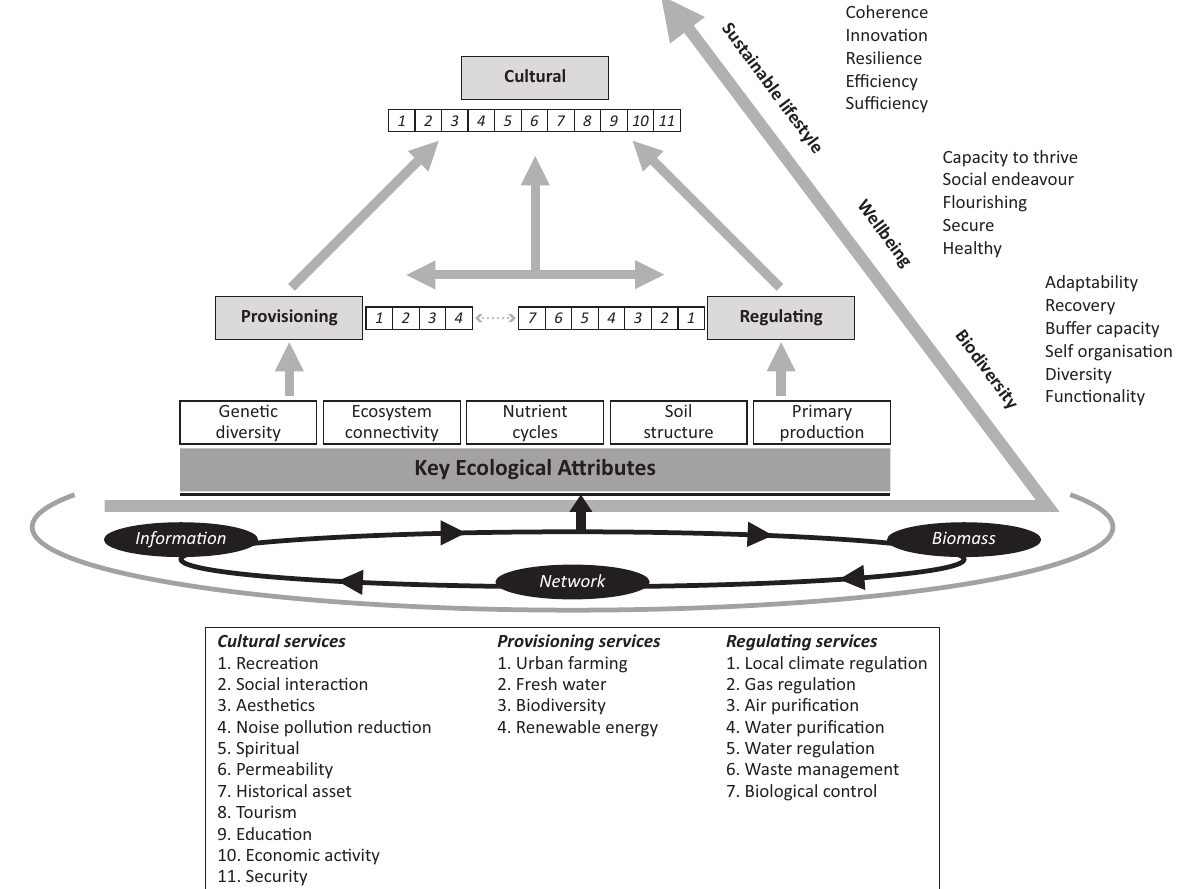
Figure 1. Ecosystem services hierarchy model emphasises the dependency of cultural services on regulating and provision‐ ing services. A sustainable lifestyle is contingent on maintaining effective ecological structure and